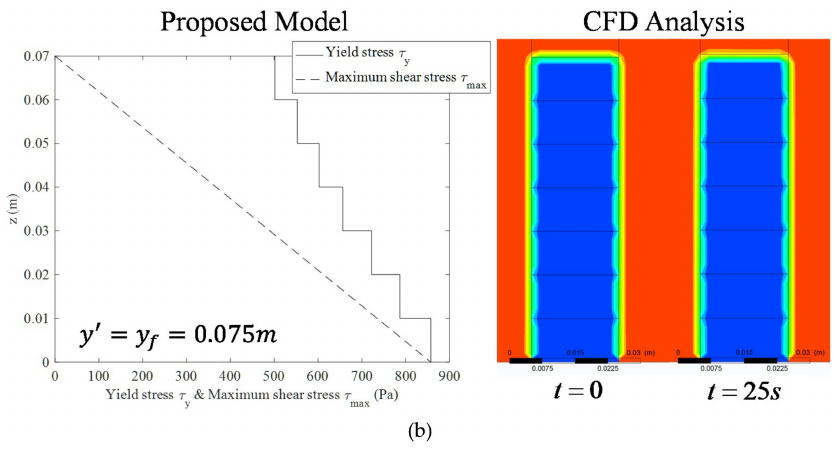
Figure 14. Validation of proposed model. ( a ) Comparison between proposed model and CFD analysis (case 1); ( b ) Comparison between proposed model and CFD analysis (case